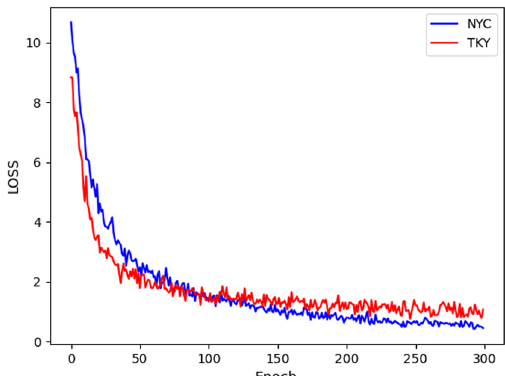
Fig. 3 Loss value with